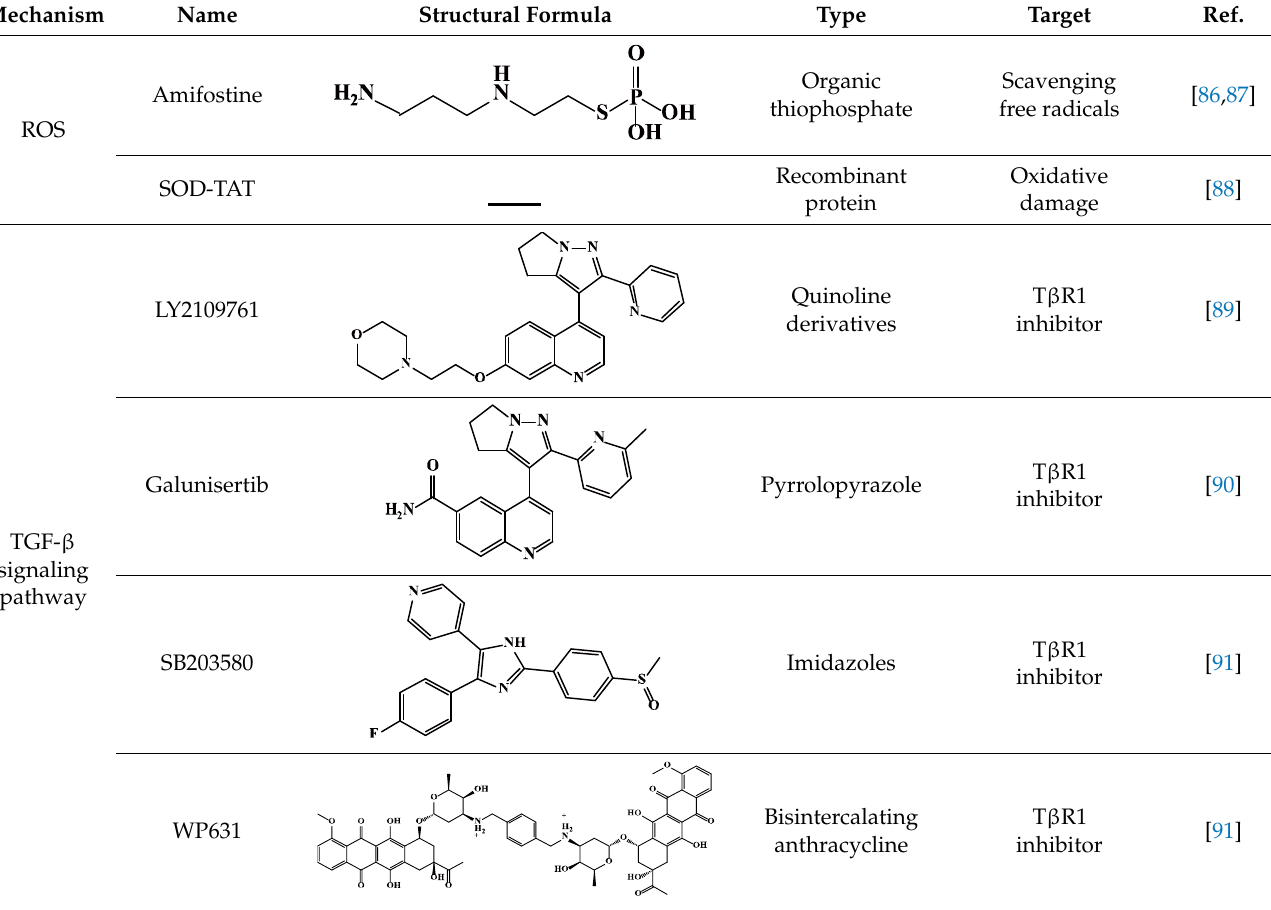
Table 1. Therapeutic strategies and inhibitors for radiation-induced pulmonary fibrosis.